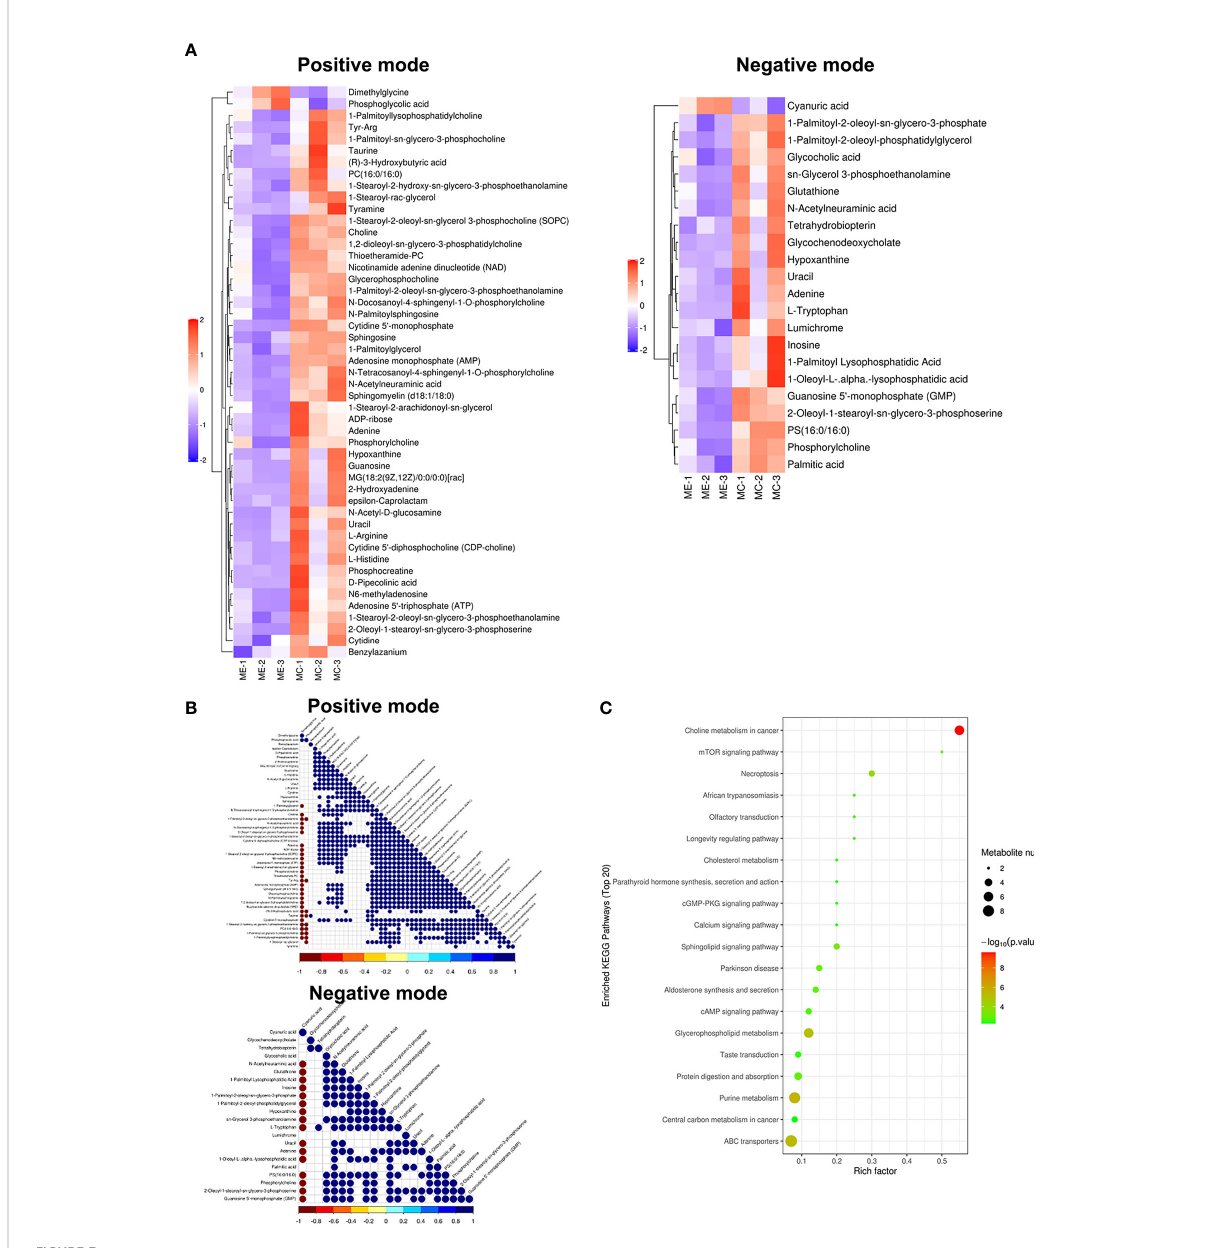
FIGURE 3 Metabolomic analysis of MGCs in endometriosis and control women. Heat map of the changes in metabolites related to MGCs in endometriosis and control women. A heat map from MGCs in the positive ion modes and negative ion modes (A) . These plots display a clear separation between normal and endometriosis metabolomes. Data of heap map plots reveal unit-variance scaling. The blue color represents the trend of reduction, and red color represents an increasing trend. Metabolite – metabolite correlation analysis of MGCs in endometriosis and control women in the positive ion modes and negative ion modes (B) . Positive correlations are shown in blue, and negative correlations are shown in red. KEGG-enriched pathways changed between endometriosis patients and control (C) . MGCs, mural granulosa cells; KEGG, Kyoto Encyclopedia of Genes and